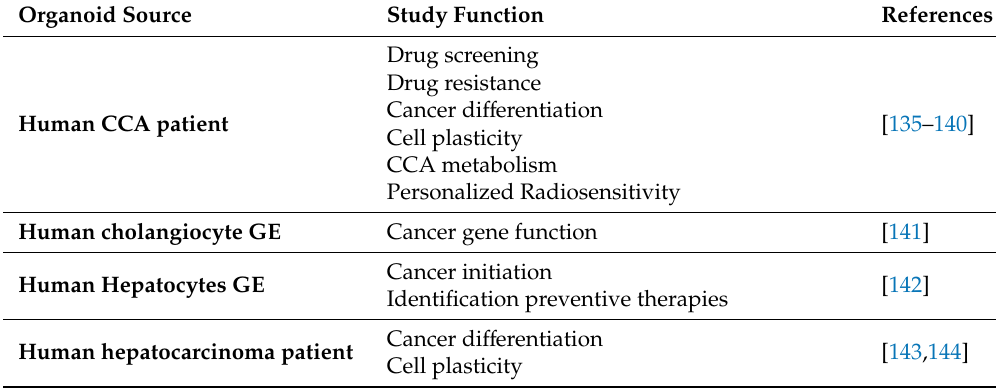
Table 2. Organoid models in CCA